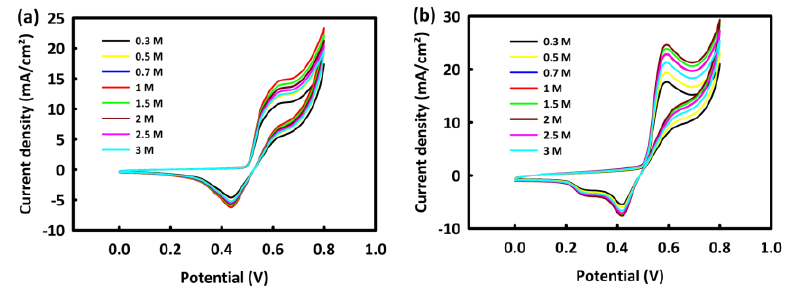
Figure 5. CV curves of MN ( a ) and MNR ( b ) at different concentrations of methanol.